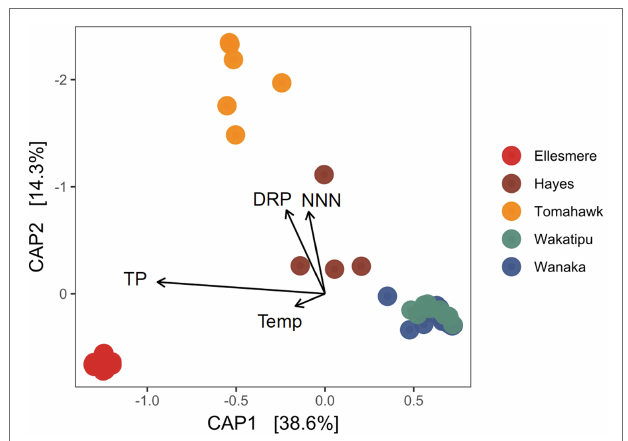
FIGURE 4 | Canonical analysis of principal coordinates (CAP) ordination of picocyanobacterial communities found in the five study lakes over 1 year of monthly sampling (February 2018 to February 2019) using a weighted Jaccard dissimilarity matrix. Constraints are significant ( p < 0.001). TP, total phosphorus; DRP, dissolved reactive phosphorus; Temp, temperature; and NNN, nitrate-nitrite